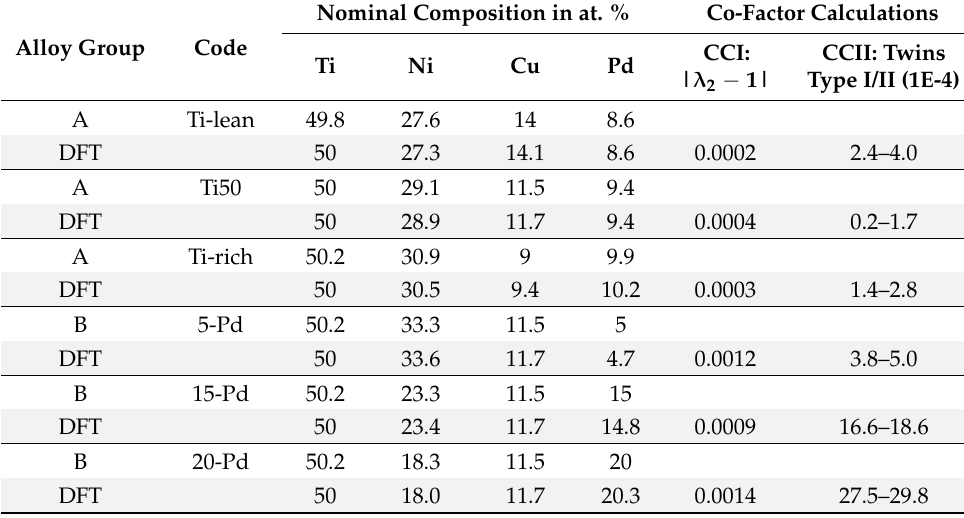
Table 1. The nominal composition of experimentally melted alloys, the compositions for DFT calculations, and the results calculated for CC I and CC II; the closer these values are to zero, the more the conditions are satisfied. Alloys can be divided into two groups: Group A consists of alloys (Ti-rich, equiatomic, Ti-lean) with a content of Pd close to 10 at. % and a Cu/Ni ratio selected to minimize | λ 2 − 1|. Group B is composed by adding Pd in expense of Ni to the reference Ni-Ti-Cu LH-SMA alloy, data from